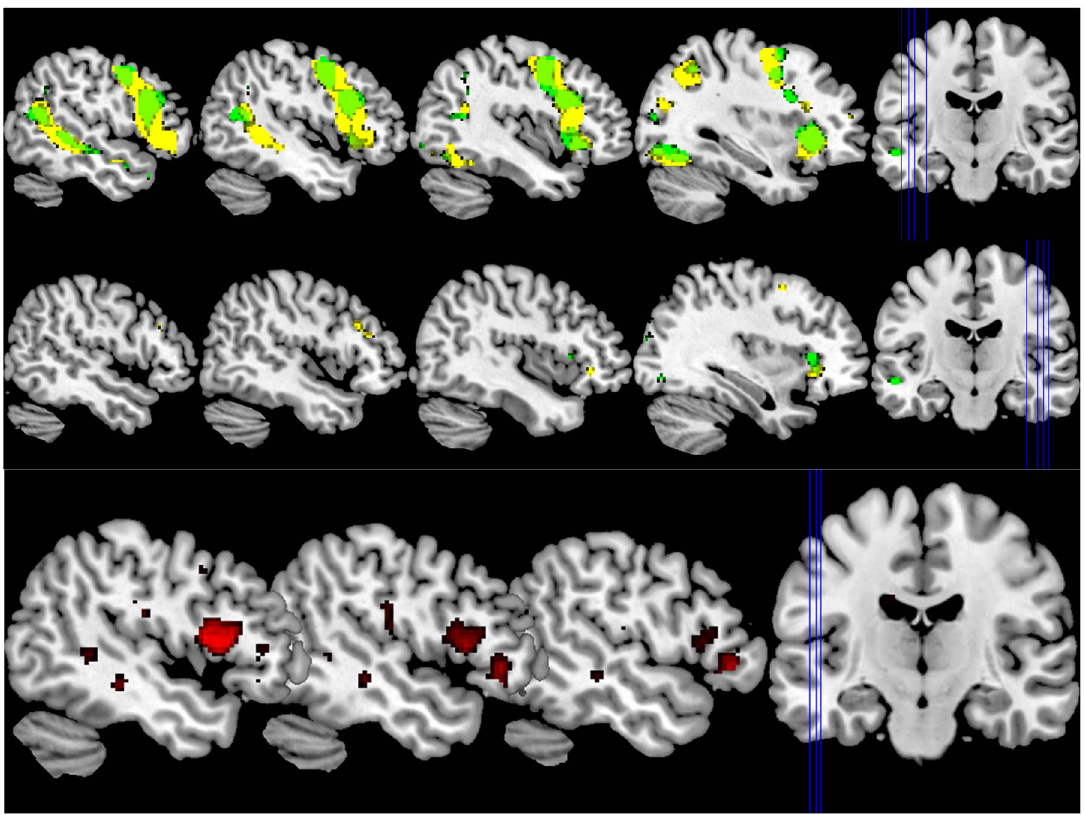
Figure 2. High Inhibition (HI) versus Low Inhibition (LI). Activation patterns for high PP depicted in yellow and for low PP depicted in green. Differential activation pattern between groups depicted in red. TOP: left hemisphere at x-coordinates (MNI-space) 2 50, 2 46, 2 42, 2 34 (from left to right). MIDDLE: right hemisphere at x-coordinates (MNI-space) 50, 46, 42, 34 (from left to right). BOTTOM: PP . HC, slices represent x-coordinates (MNI-space) 2 50, 2 46, 2 42 (from left to right).